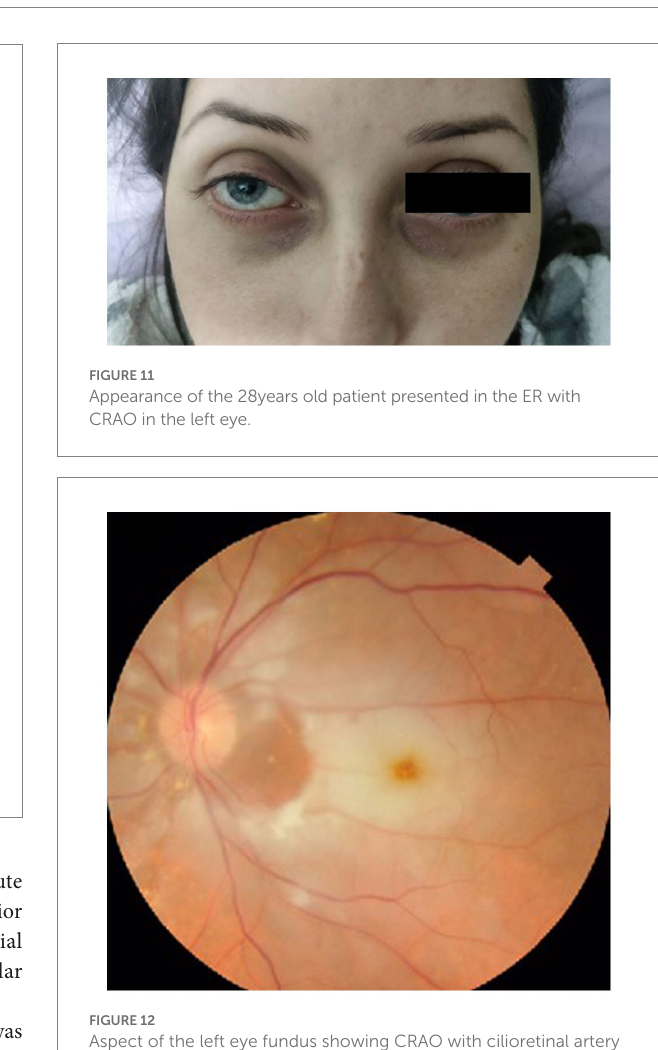
FIGURE 12 Aspect of the left eye fundus showing CRAO with cilioretinal artery